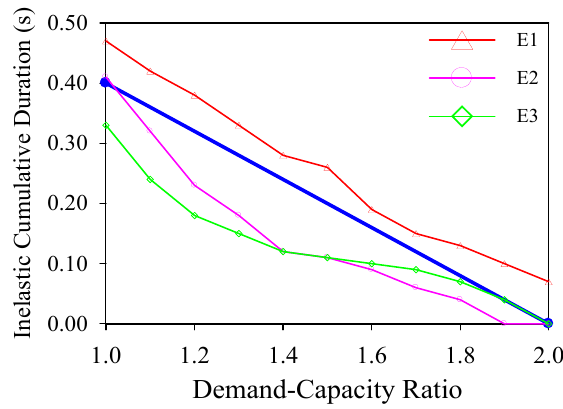
Fig. 10. Performance curves at nodal point 48 of the arch dam for Case E1, E2, and E3.